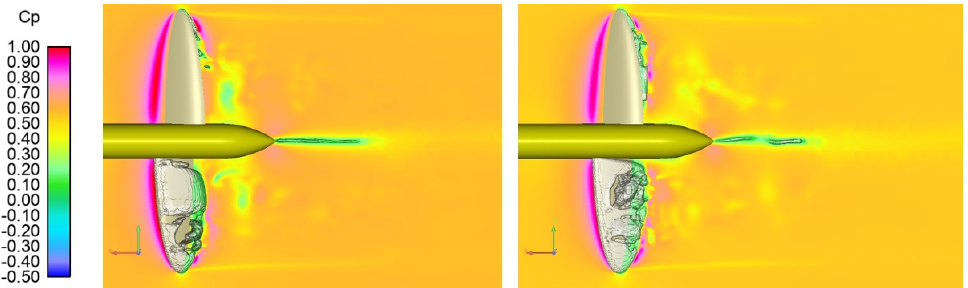
Figure 23. Snapshot of VOF ( left ) and EE ( right ) CFD simulations of the pressure coefficient at the mid-plane in the vertical direction.